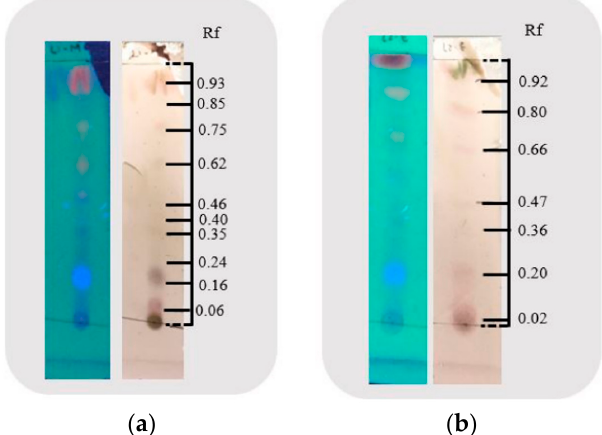
Figure 1. Thin-layer chromatographic of ( a ) EG − methanolic and ( b ) EG − ethanolic extracts.